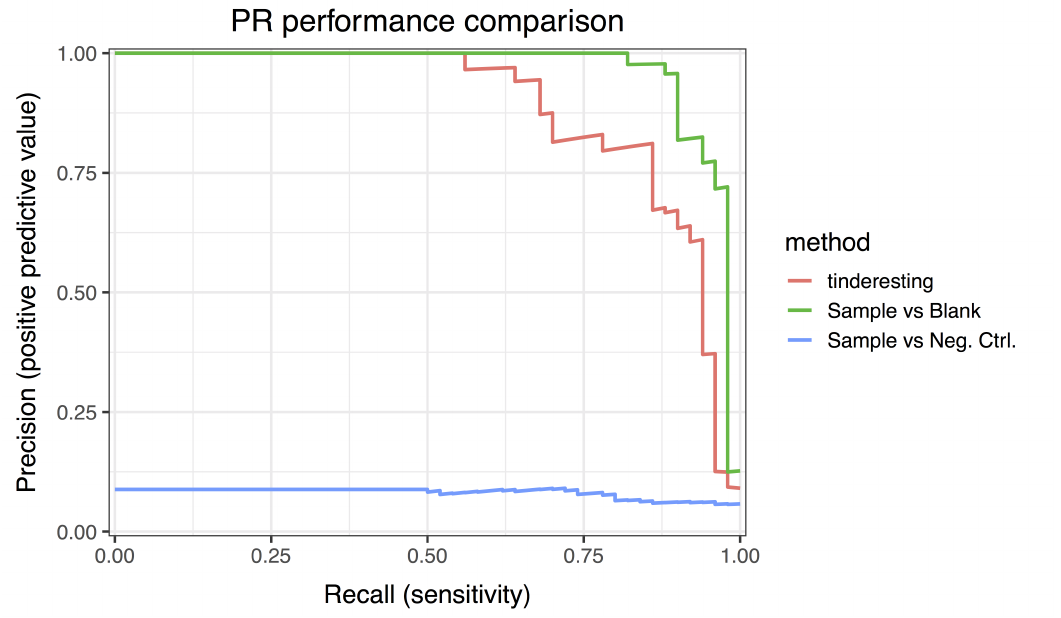
Figure 7. Receiver operator characteristic curves of tinderesting and EDGE. The area under the ROC curve (AUC) values are 0.977, 0.992 and 0.675 for tinderesting, sample vs. blank and sample vs. negative control, respectively.